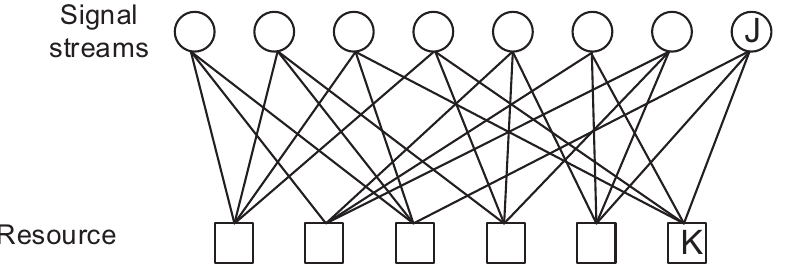
Figure 7. Factor graph of 8 by 6 SCMA